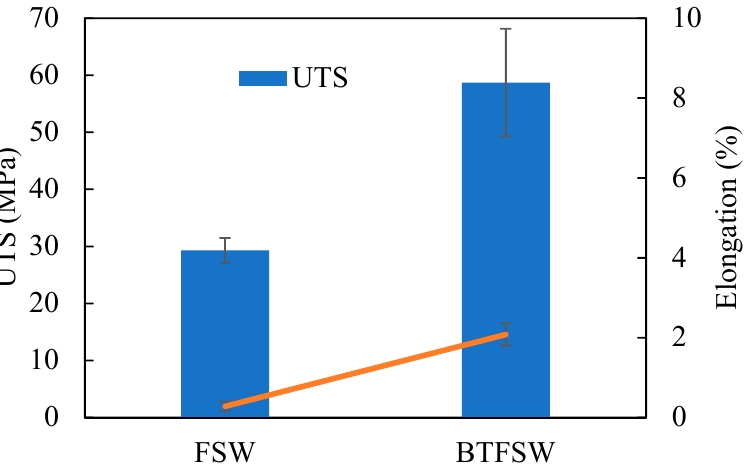
Figure 7. Tensile properties of dissimilar Al/Cu joint produced by FSW and BTFSW.